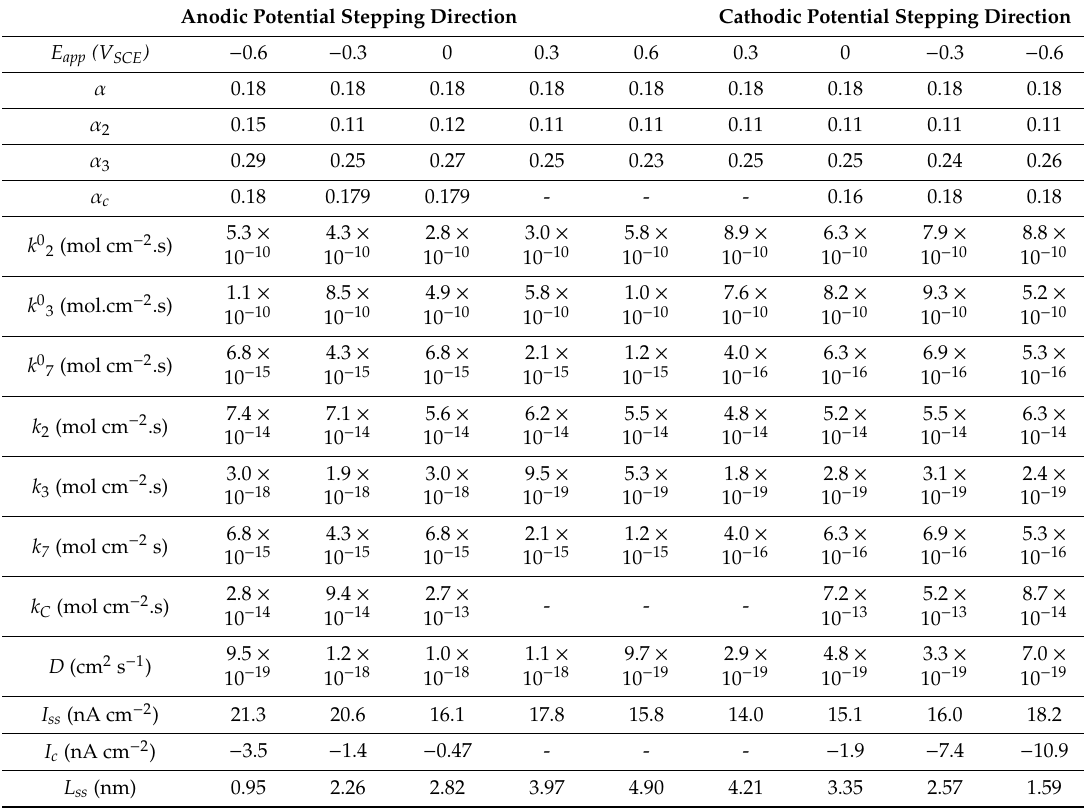
Table 3. Kinetic parameters of passive layer formation obtained by optimization of the EIS results based on the MPM